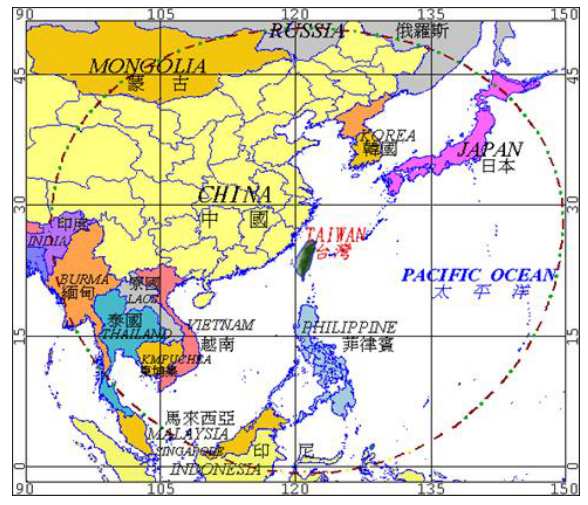
Figure 1: Reception coverage of the Satellite Receiving Station in CSRSR, NCU, Taiwan.